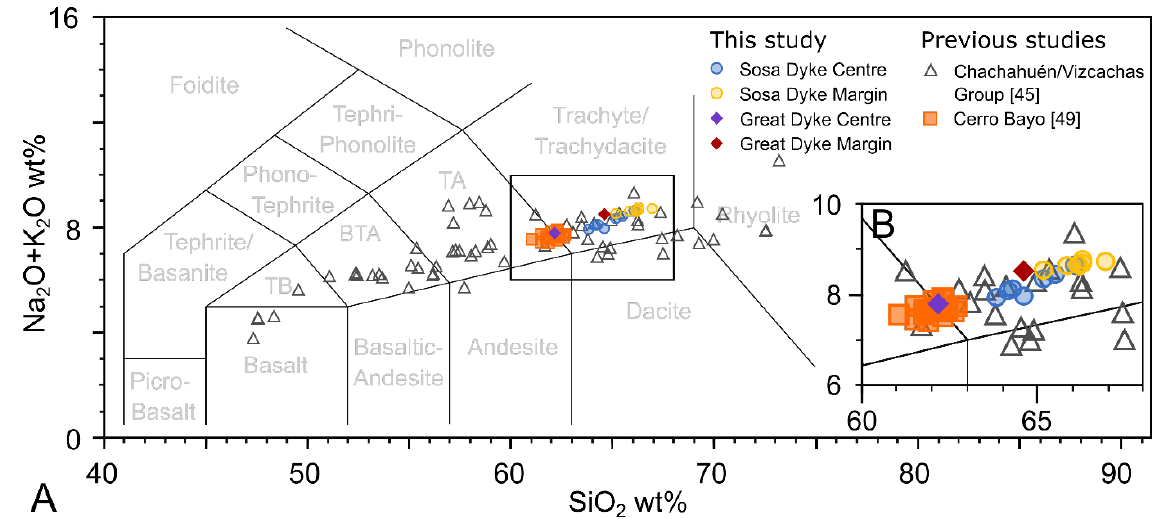
Figure 8. Classification of the Chachahuén rocks. ( A ) TAS-Diagram showing data from previous analysis and this study. ( B ) Zoom to of ( A ).